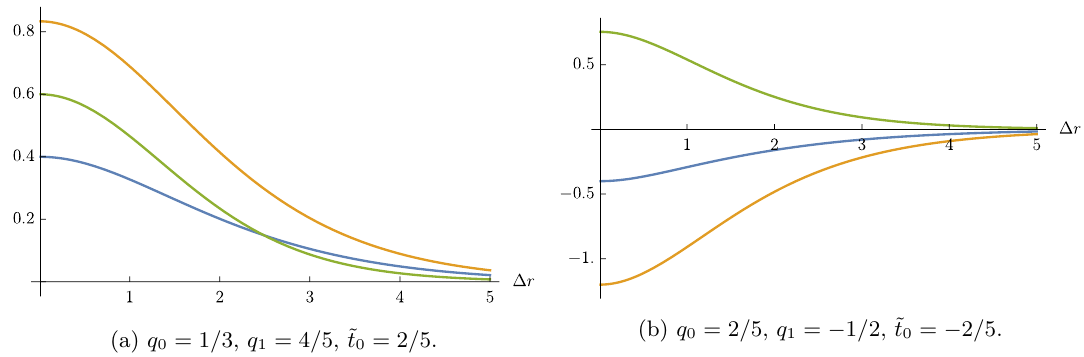
Figure 1. Example of numerical solutions for different values of q I and t 0 . Orange: τ ( r ) , blue: ˜ τ ( r ) , green: X ( r )